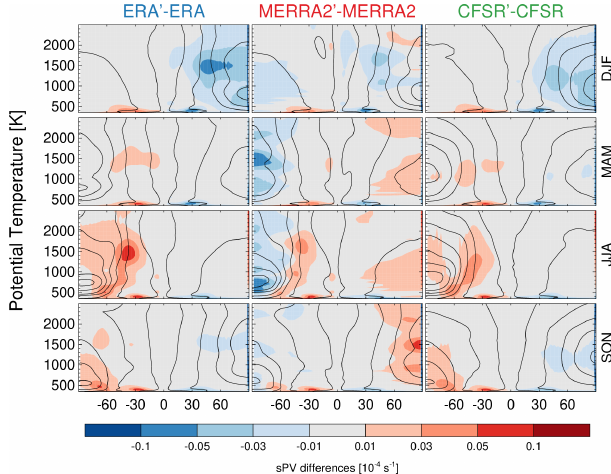
Figure 5. Differences between the sPV from each reanalysis pro- vided vorticity or PV and the sPV computed from that reanalyses’ horizontal wind, pressure, and temperature fields. Overlaid contours show each reanalyses’ climatology based on that reanalyses’ pro- vided